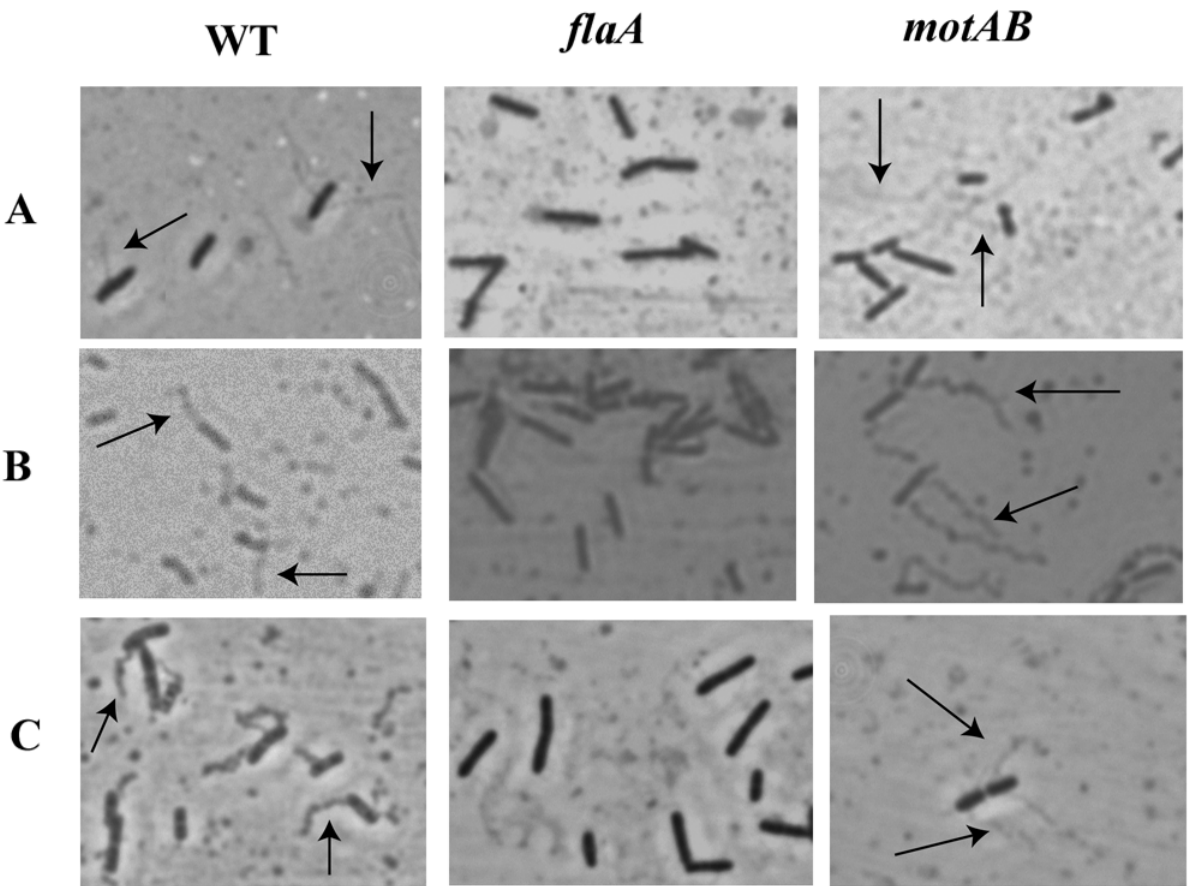
Figure 2. Flagellar stains of wild type and mutant strains. Some flagella are indicated by arrows. Shown are representative panels from the three different strain backgrounds: Row A) 10403 strain background, Row B) RM2387 strain background, Row C) RM2992 strain background. All micrographs were taken at 1000 6 magnification.